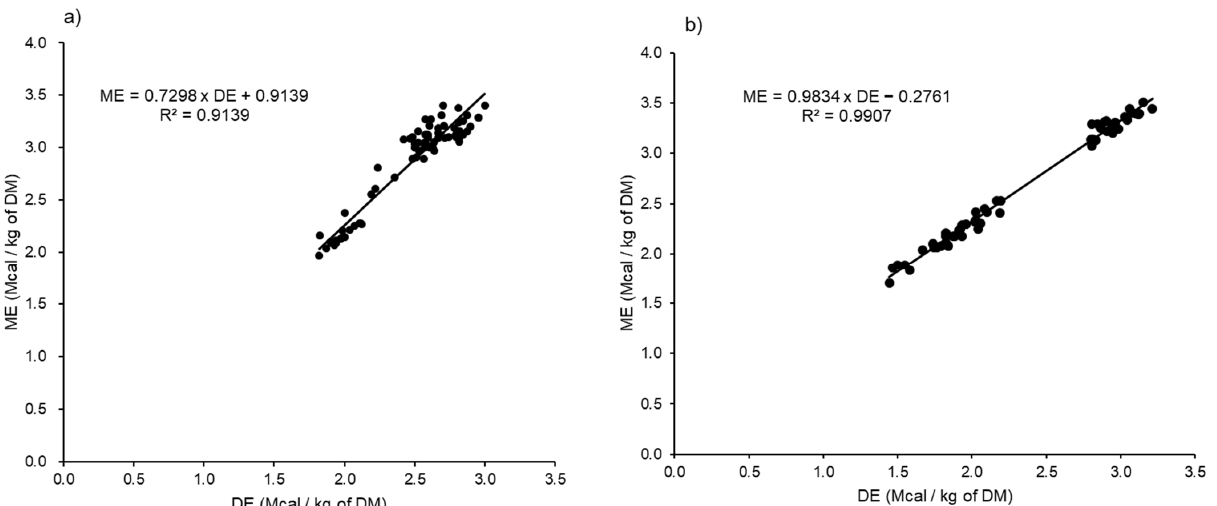
Figure 3. Relationship between the digestible energy (DE) and metabolizable energy (ME) concentrations by body weight: below 350 kg ( a ) and above 350 kg ( b ) (unadjusted citation for random differences in the intercepts). DM; dry matter. Table 3. Adjusted and unadjusted equations of the relationships between the digestible and metabolizable energy of beef cattle according to gender and body weight.